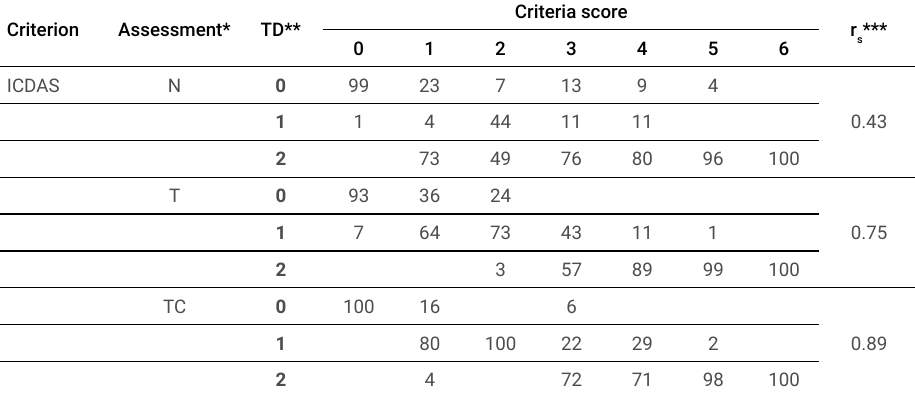
Table 2. Percentages of treatment decisions according to ICDAS and Nyvad criteria used by dental students in three assessments.